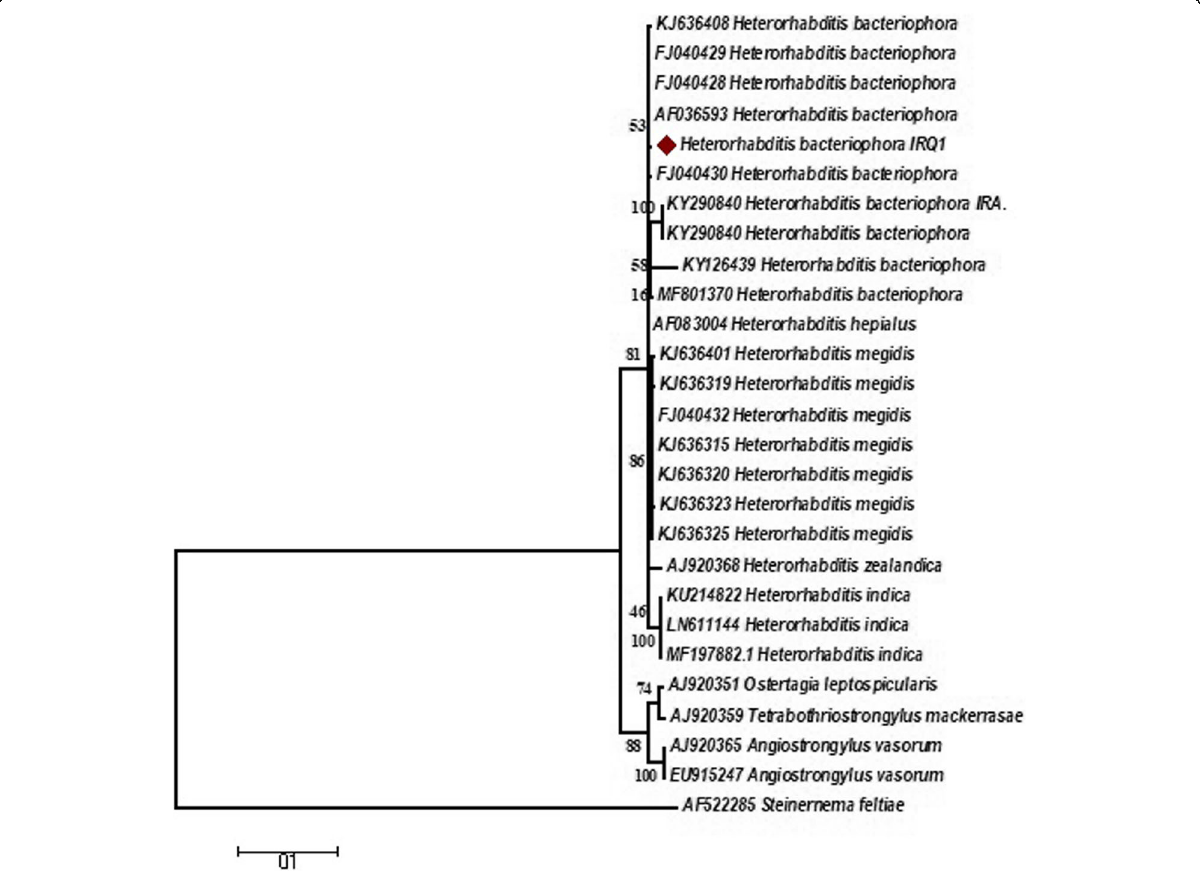
Fig. 2 Phylogenetic relationships of Heterorhabditis isolate with 26 isolates of Heterorhabditis species based on 18S sequences as inferred from maximum likelihood (ML) analyses. 18S sequence of Steinernema feltiae (AF522285) was used as the outgroup. Support values are presented near the nodes in the form: bootstrap in